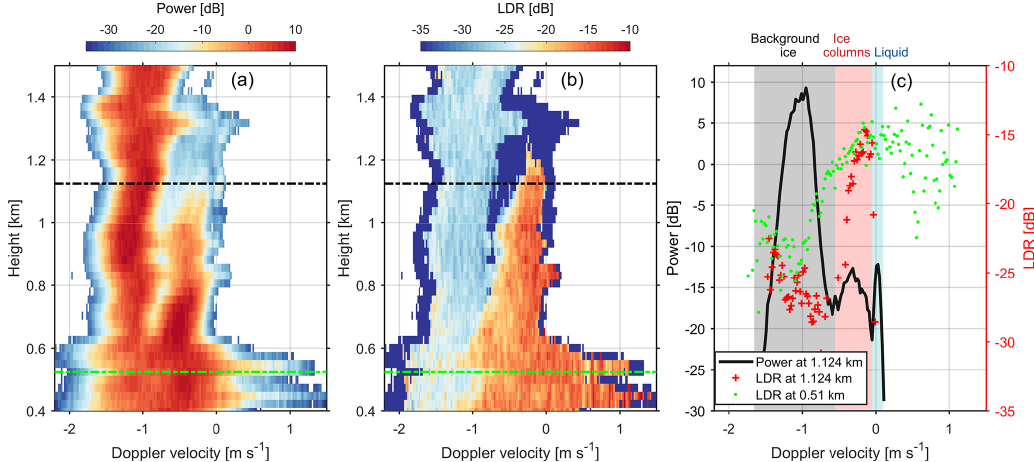
Figure 1. HYDRA-W Doppler spectral (a) power and (b) LDR at 2 February 2018 07:56:38UTC. (c) Spectral power (black line) and LDR (red crosses) at 1.124km as marked by the black dot dashed lines in (a) and (b) and LDR (green dots) at 0.51km as marked by the green dot dashed lines in (a) and (b) . The gray, red and blue shaded areas in (c) indicate background ice falling from above, newly formed ice columns and supercooled liquid, respectively, at 1.124km. Negative velocity indicates downward motion.